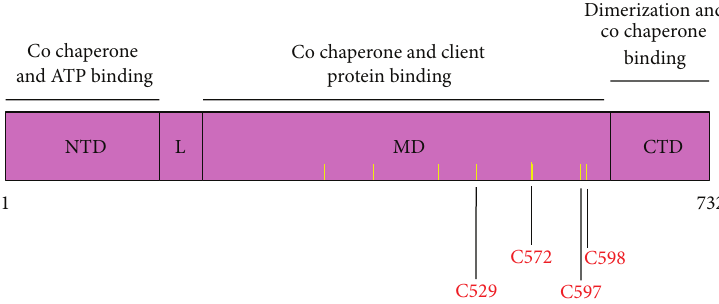
F 4: Domain structure of human Hsp90